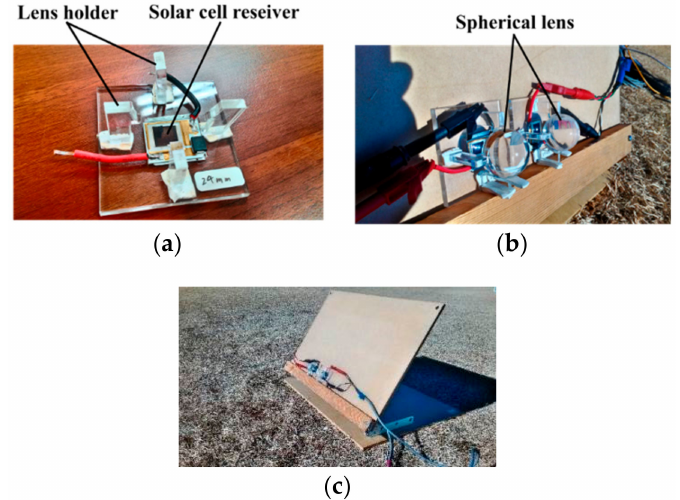
Figure 14. Test module photographs: ( a ) Solar cell receiver, ( b ) lens-cell module, and ( c ) measurement